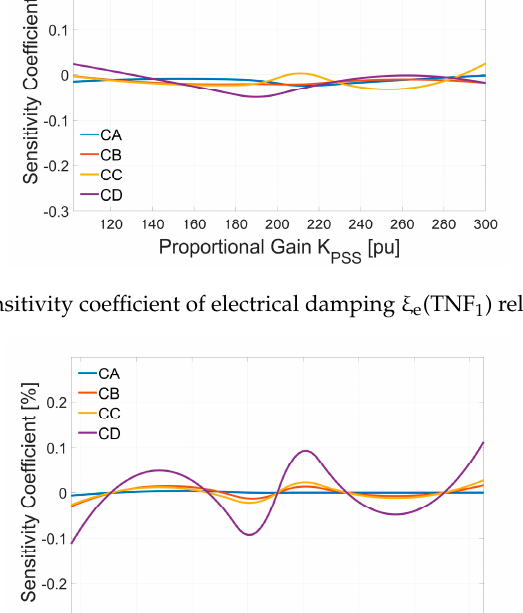
damping ξ e (TNF 1 ) related to K PLL .